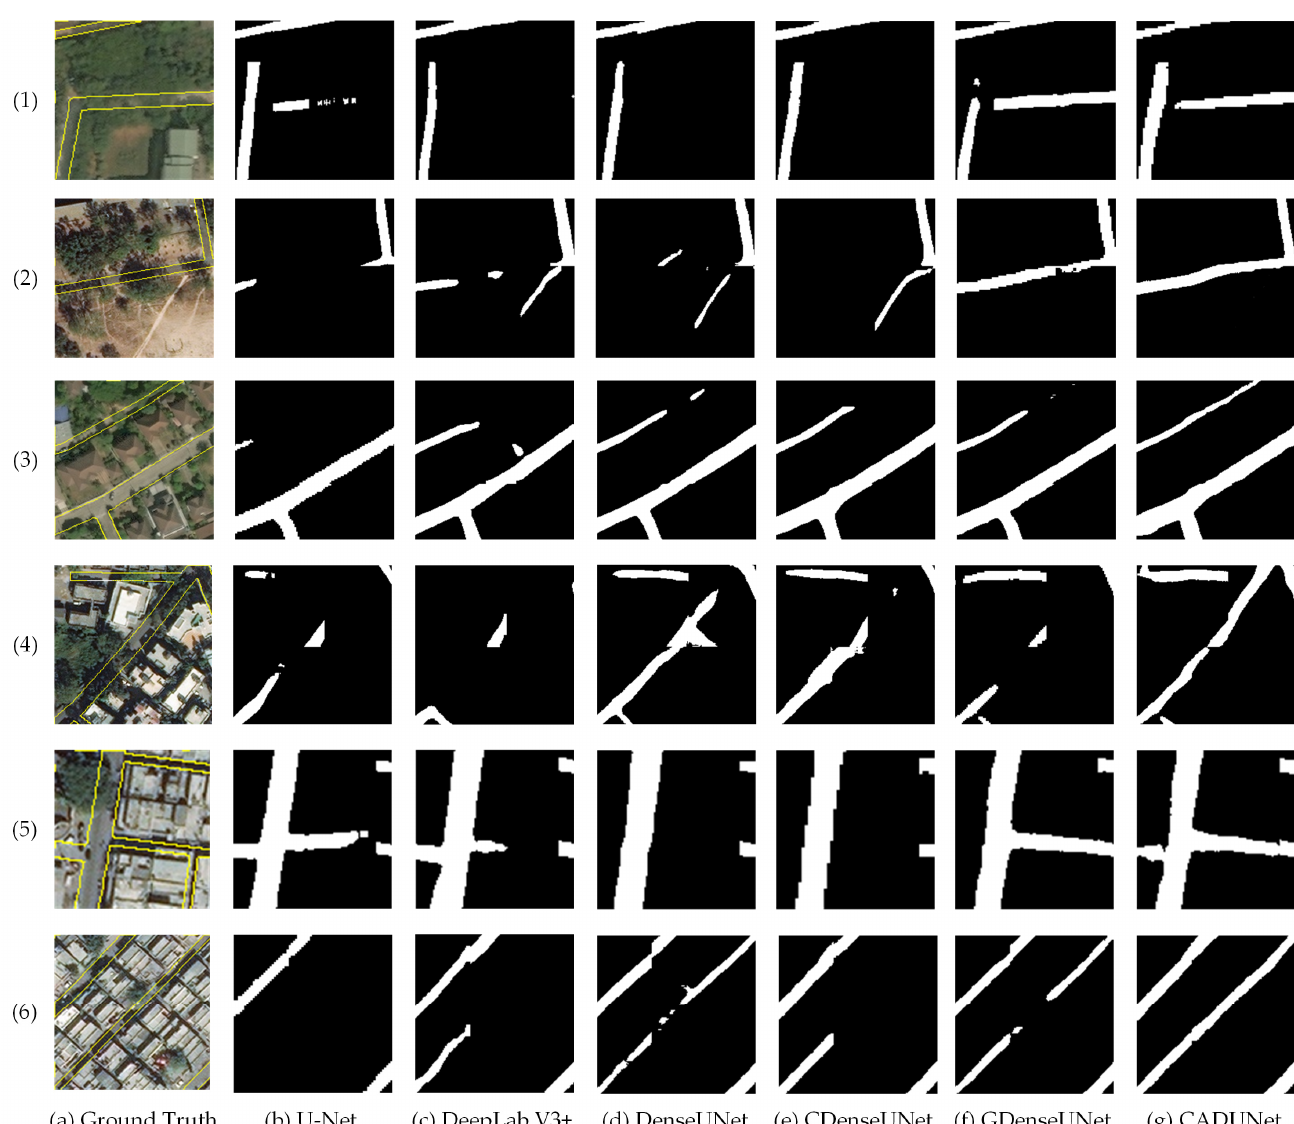
Figure 7. Pavement integrity and sideline smoothness of the extracted roads in the CVPR dataset. ( 1 , 2 ) The partial roads occluded by tree canopies in rural areas; ( 3 , 4 ) The partial roads occluded by tree canopies in suburbs; ( 5 , 6 ) The partial roads occluded by urban high-rise buildings in urban areas.